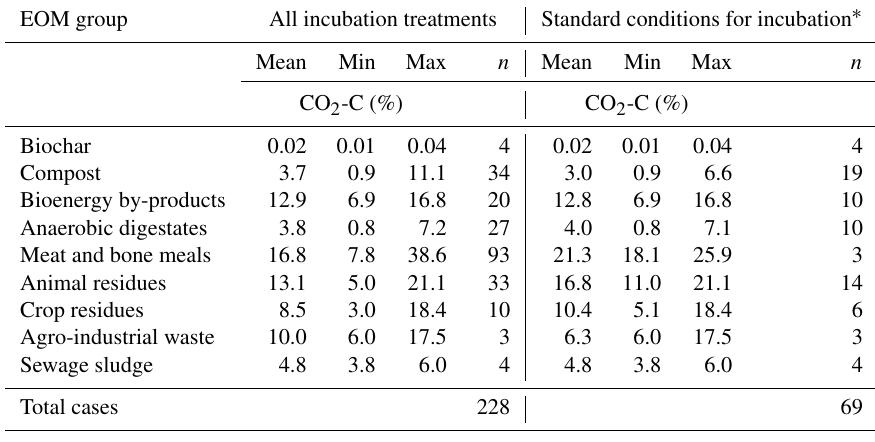
Table 5. Cumulative extra CO 2 -C emitted in amended soil (% of added C) for each exogenous organic matter (EOM) group for all incubation treatments and incubation performed under standard conditions. EOM group All incubation treatments Standard conditions for incubation ∗